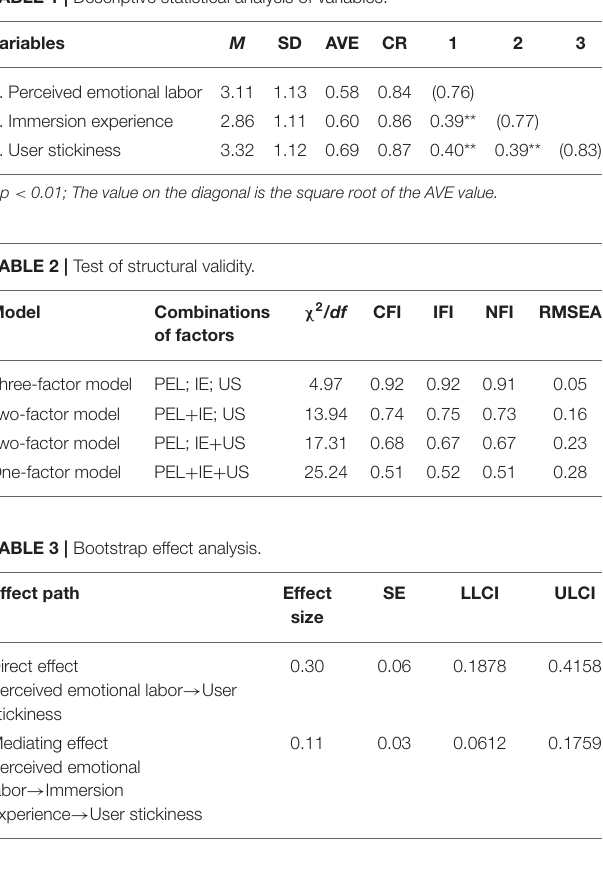
TABLE 1 | Descriptive statistical analysis of variables.